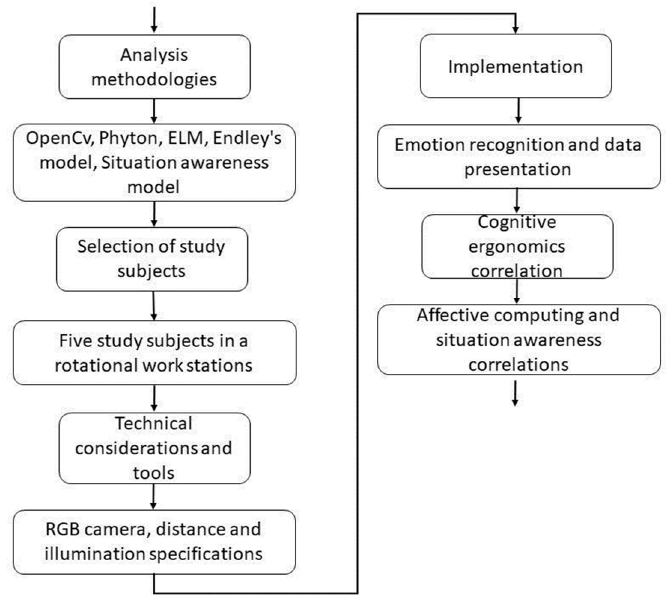
Figure 2. Activities and expected results of the stages of implementation of computer and ergonomic techniques.